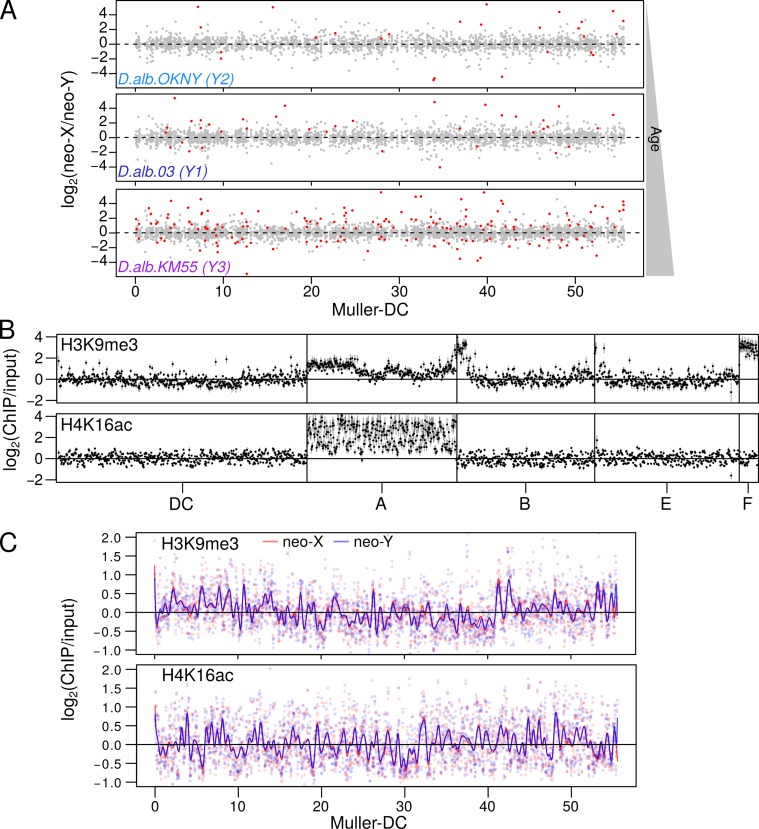
Absence of chromosome-wide differentiation.A. Based on allele-specific RNA-seq, the corrected fold-difference (see Materials and methods) between the expression of neo-X and neo-Y alleles of each gene is plotted for neo-Ys of different ages: OKNY (Y2), 03 (Y1), and KM55 (Y3). Red points represent genes with significant allele bias. B. Enrichment of the repressive heterochromatin (H3K9me3, top) and dosage compensation (H4K16ac, bottom) marks for strain 03 are plotted in 50kb windows genome-wide; error bars represent the standard errors inferred from quadruplicates. C. The indistinguishable enrichment profiles of the neo-X (red) and neo-Y (blue) for the two chromatin marks are plotted with Loess smoothing curves overlaid. Correlations of the neo-X and neo-Y enrichments at individual windows can be found in S13 Fig.